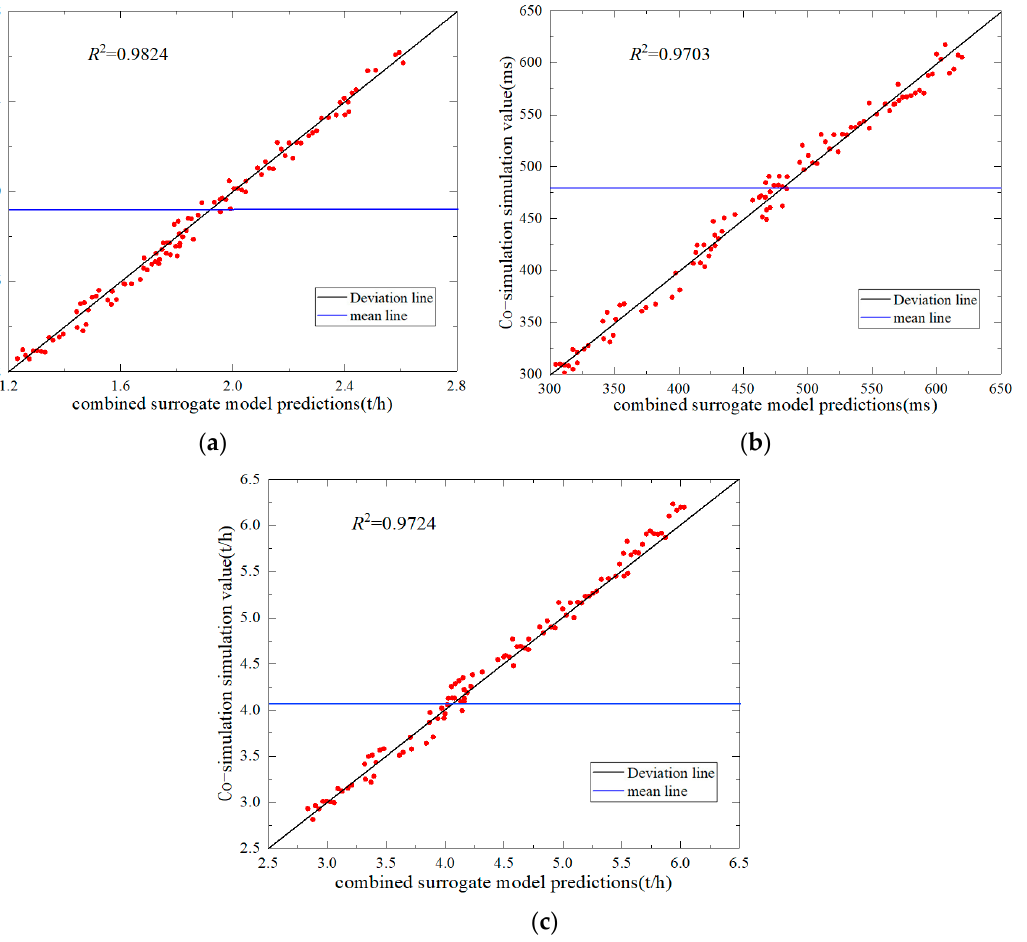
Figure 18. Fitting effect diagram of each output response of the combined surrogate model. ( a ) Fitting effect diagram of δ ; ( b ) fitting effect diagram of t s ; ( c ) fitting effect diagram of e .